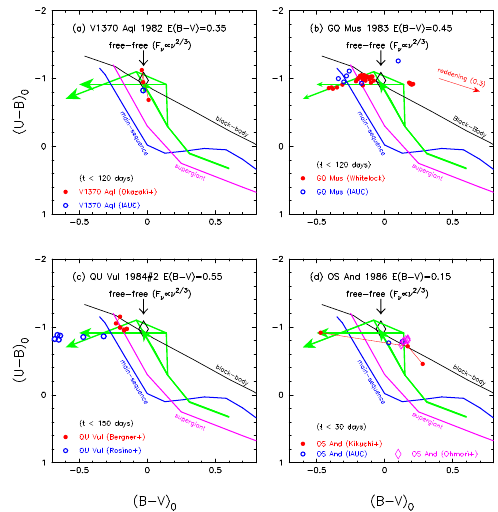
Figure 6: (a) V1370 Aql, (b) GQ Mus, (c) QU Vul, and (d) OS And.